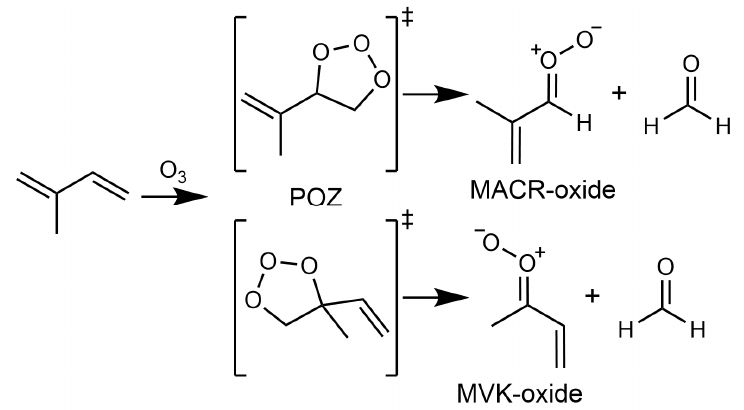
Scheme 1. Reaction scheme illustrating the generation of anti -MACR-oxide + formaldehyde and syn -MVK-oxide + formaldehyde from the ozonolysis of isoprene.